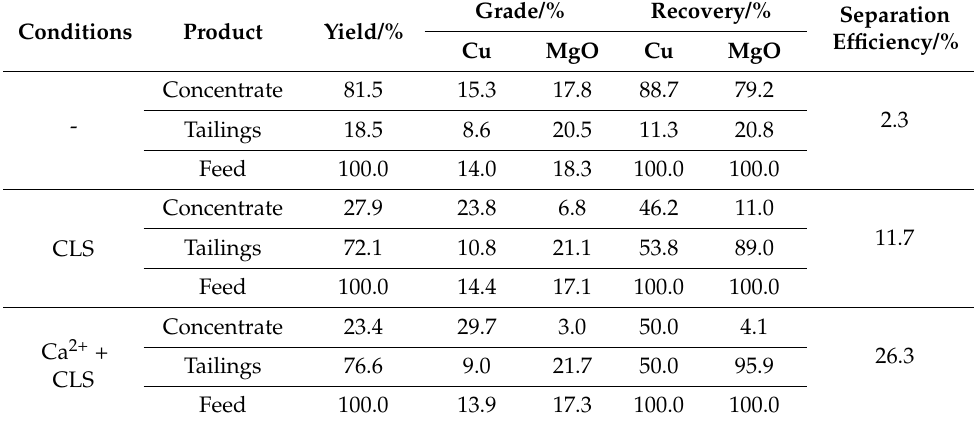
Effect of CLS on flotation performance with/without the presence of Ca 2+ ions